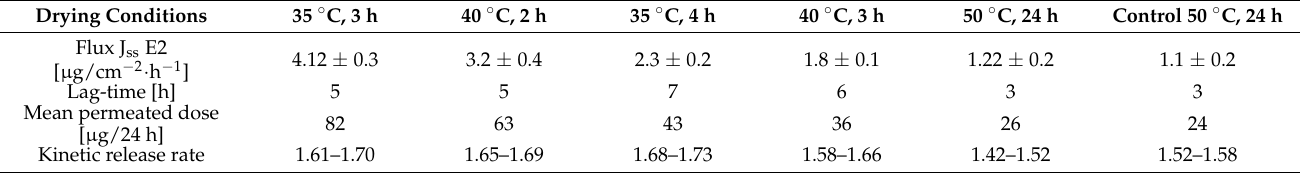
Table 2. Flux values, lag time, mean delivered dose and kinetic release rate of the prepared patches.